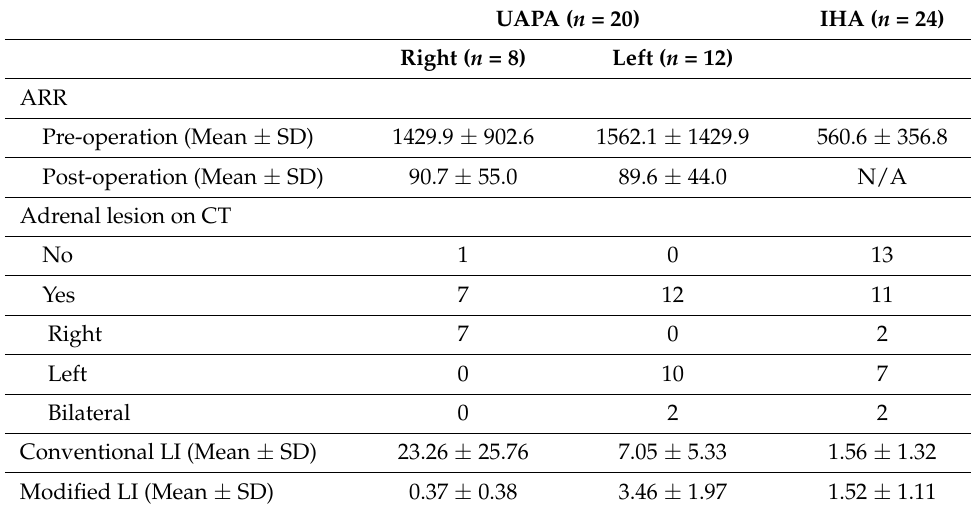
Table 2. The results of rt. APA vs. Lt. APA vs.